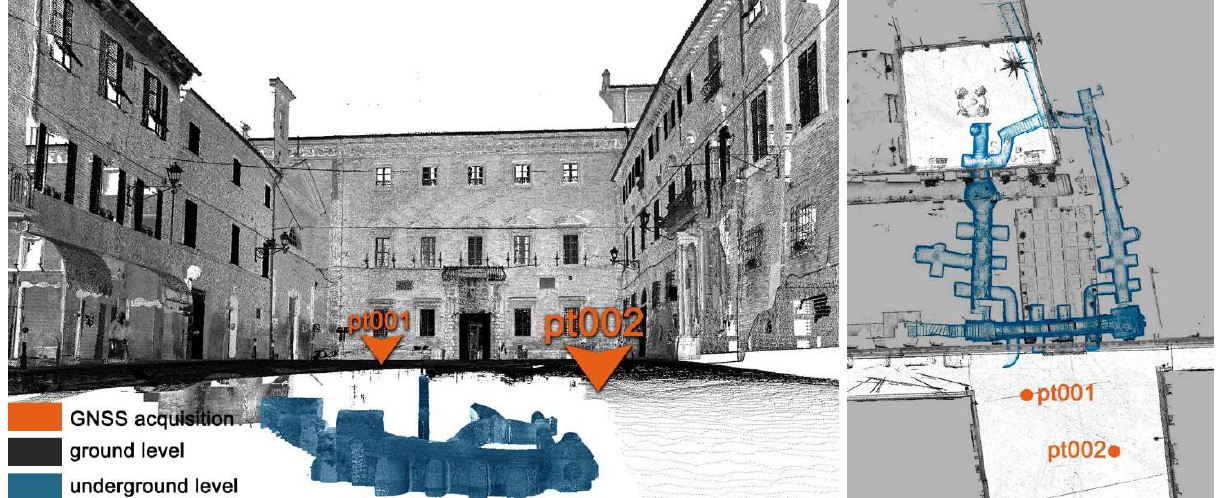
Figure 6: GNSS acquired geodetic Ground Control Points detected in the TLS point cloud.